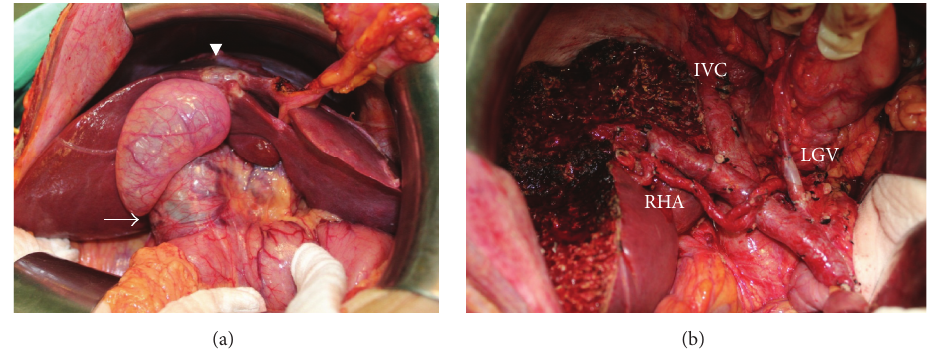
Figure 2: Intraoperative findings. (a) Significant dilatation of extrahepatic bile duct (arrow) and mass-forming lesion at segment 4 (arrow head). (b) Operative field after removal of specimen. IVC: inferior vena cava, LGV: left gastric vein, and RHA: right hepatic artery.